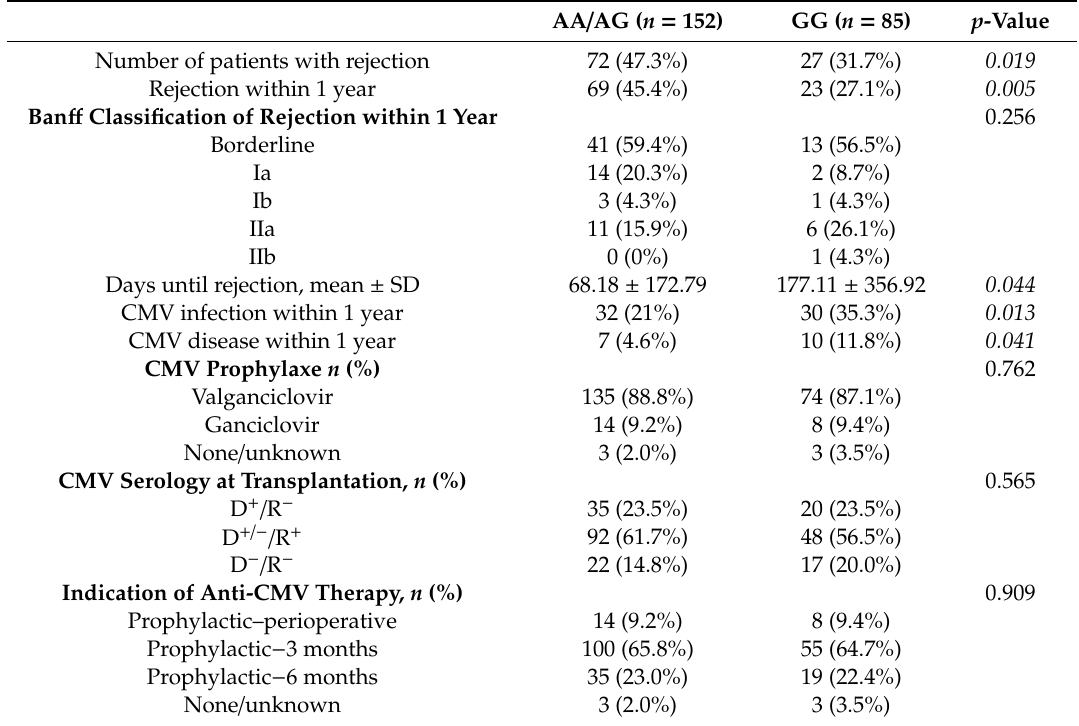
Table 2. Characteristics of kidney transplant patients ( n = 237) at follow-up stratified by the AQP3 A( − 1431)G